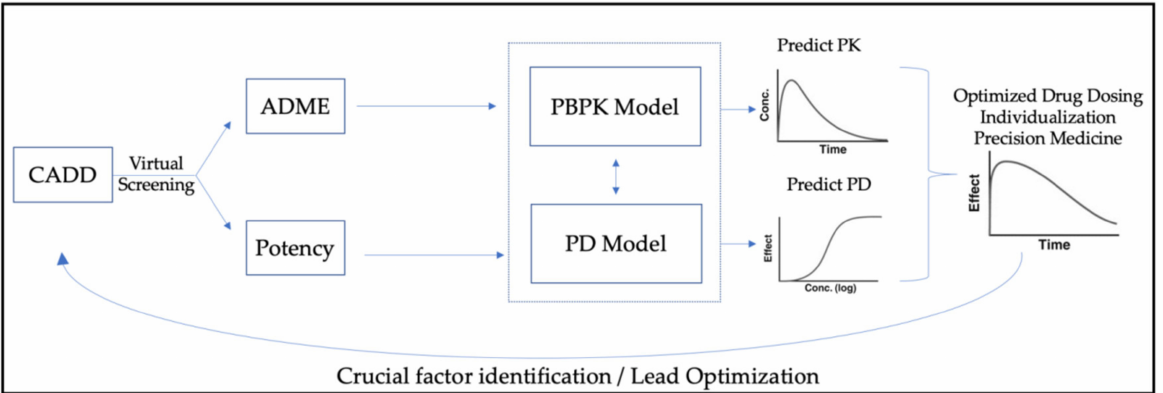
Figure 2. Combining PBPK and CADD methodological tools to accelerate the drug development process. PBPK modeling identifies sources of PK variability and predicts PK profiles in specific target organs and tissues. When combined with PD modeling, PBPK also generates predictive safety and efficacy profiles. The produced outcomes are utilized in a “reverse translation” approach to inform CADD. Iterative cycles of inputs and outputs may elucidate the optimal structure and lead to the best combination of PK, PD potency, as well as specific ADME tissue-targeted pharmacological